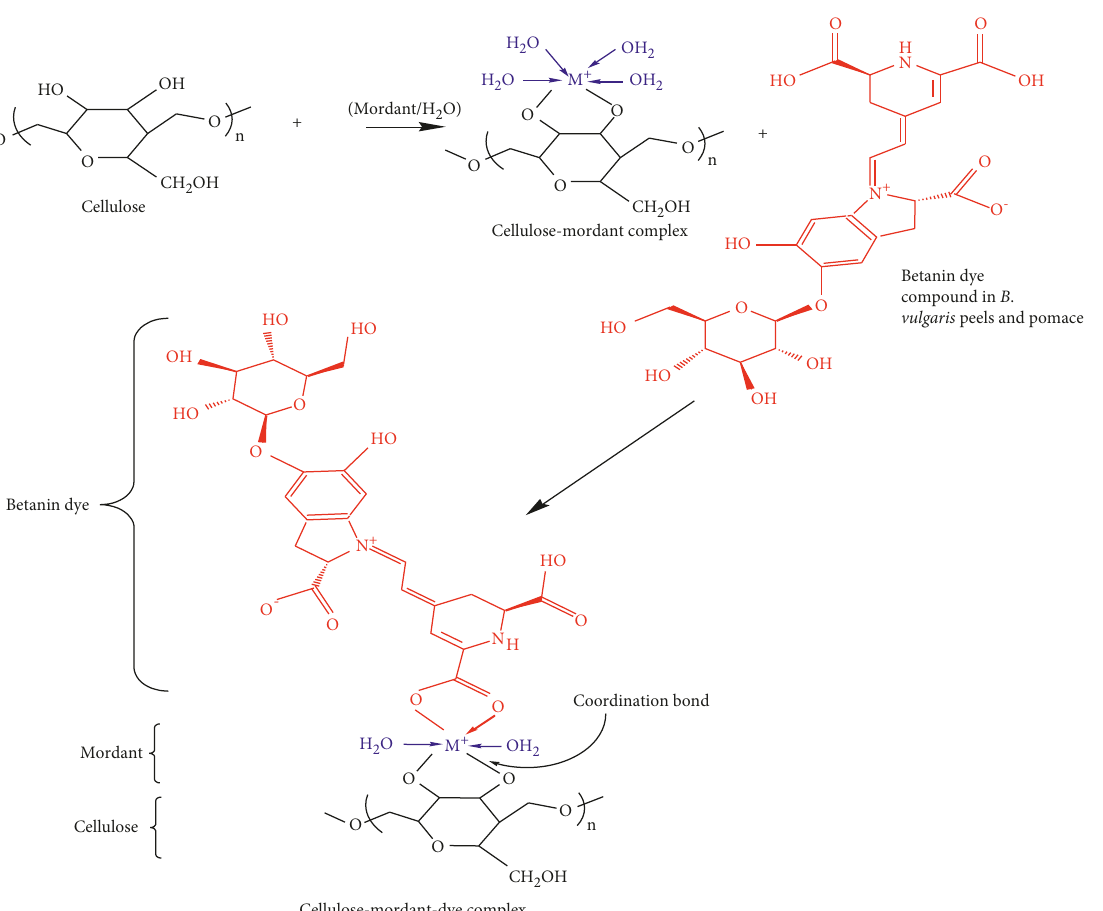
Figure 5: A plausible interaction of cotton fibre-mordant-betanin dye complex. M represents the metal ion from the